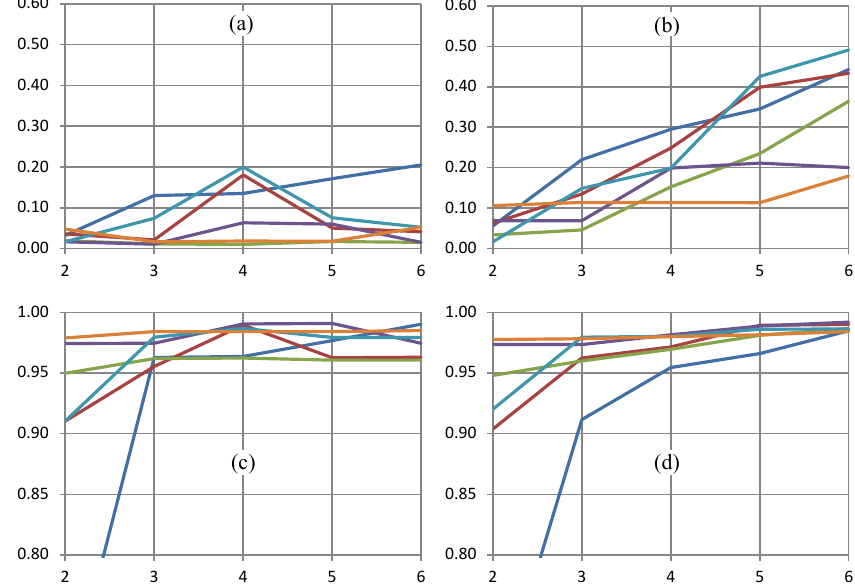
Figure 11. Exemplary values of storage coefficient k (day − 1 ) in the SC2 model (a) and Nash one (b) , and Nash–Sutcliffe efficiency index E f for the SC2 model (c) and the Nash one (d) versus the number of reservoirs (the ´Scinawka River catchment, water gauge Gorzuchów; six independent recession curves).